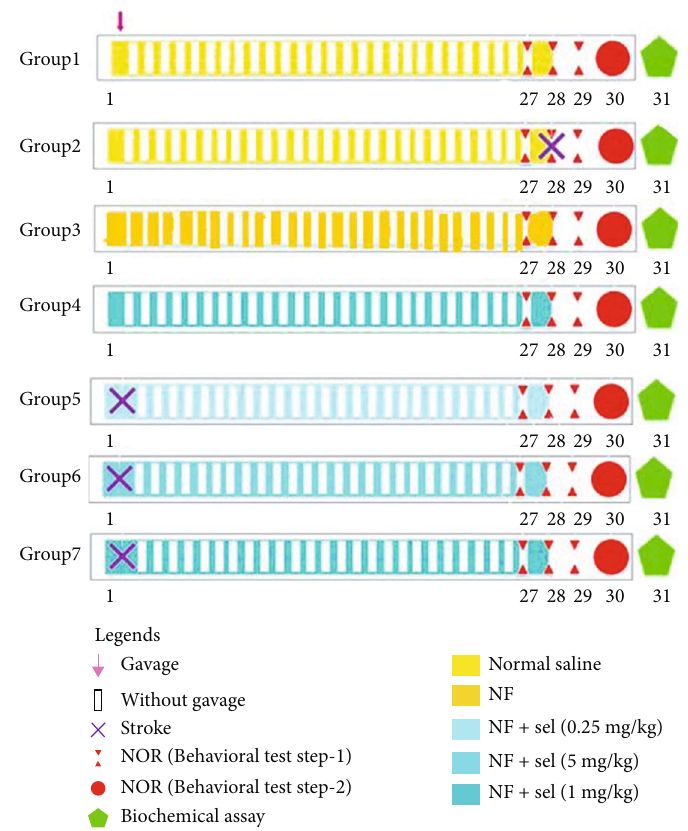
Figure 1: Timeline of stroke procedure, treatment behavioral, and biochemical tests. The rats were divided into 7 groups ( n = 12 animals in each group) and were treated as described in “ Materials and Methods. ” Each experimental animal group consists of 7-8 animals in behavioral assessments, 3 animals in molecular evaluations, and 2-3 animals in histopathological assays. At the end of treatments, the animals were subjected to the behavioral assessment. In the next step, the e ff ects of drug treatments on the biochemical factors were investigated in the di ff erent sets of